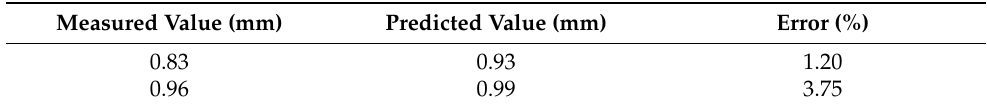
Table 6. Percentage error of L s .